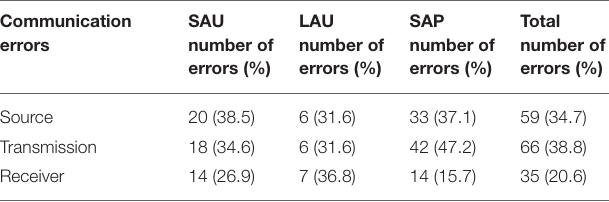
TABLE 7 | Distribution by type of communication error for each hospital (see Figure 1 for hospital abbreviations). Communication SAU errors number of